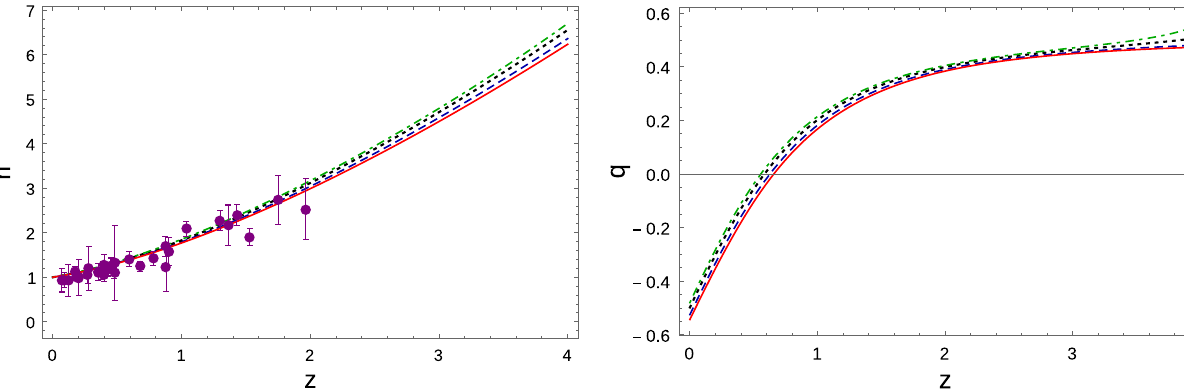
¯ α = − 0 . 45 (dot-dashed curve), respectively. For the Hubble function, we have also plotted the observational data together with their errors [168–176]. The (cid:7) CDM curve is depicted as a red solid